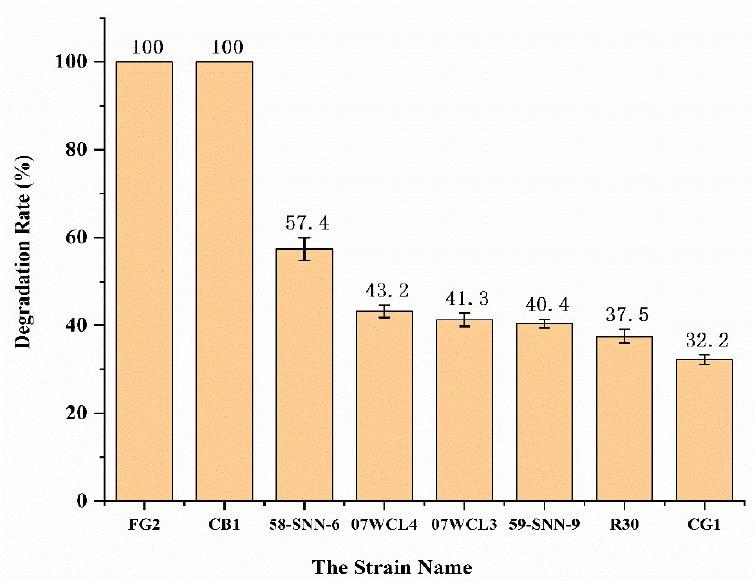
Figure 2. Biodegradation of malathion by strain FG2 and strain CB1 in M1 medium containing 500 mg/L malathion. Data are presented as mean and standard error ( n = 3).